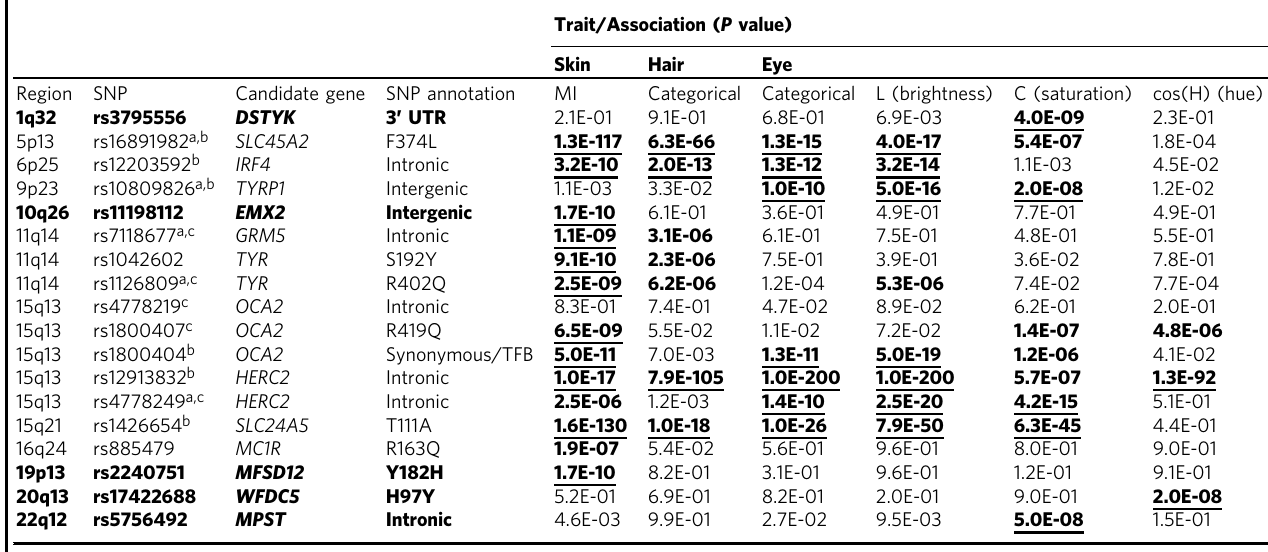
Table 1 Features of index SNPs in genome regions associated with pigmentation traits in the CANDELA sample Trait/Association ( P